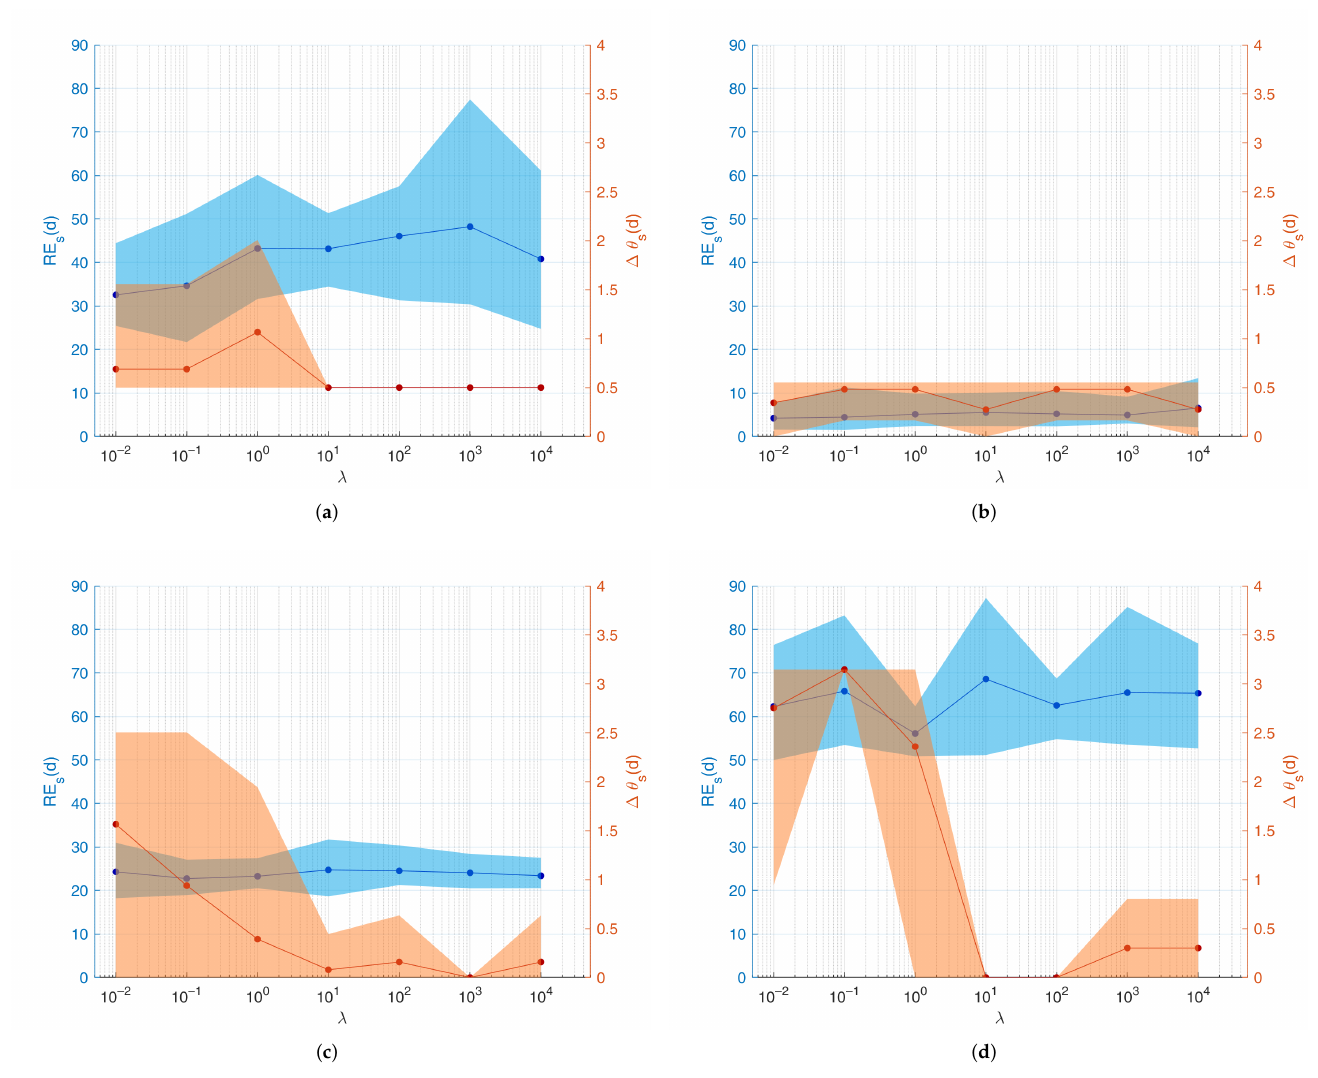
Figure 6. Analysis of scalarization factor λ for the four scan angles: for each plot, the left axis shows the average values of RE s (solid line) and the confidence interval of 90% (light area). Similarly, the right axis represents the same values for the ∆ θ s . ( a ) Results for θ s = 10 ◦ ; ( b ) Results for θ s = 20 ◦ ; ( c ) Results for θ s = 30 ◦ ; ( d ) Results for θ s = 40 ◦ .